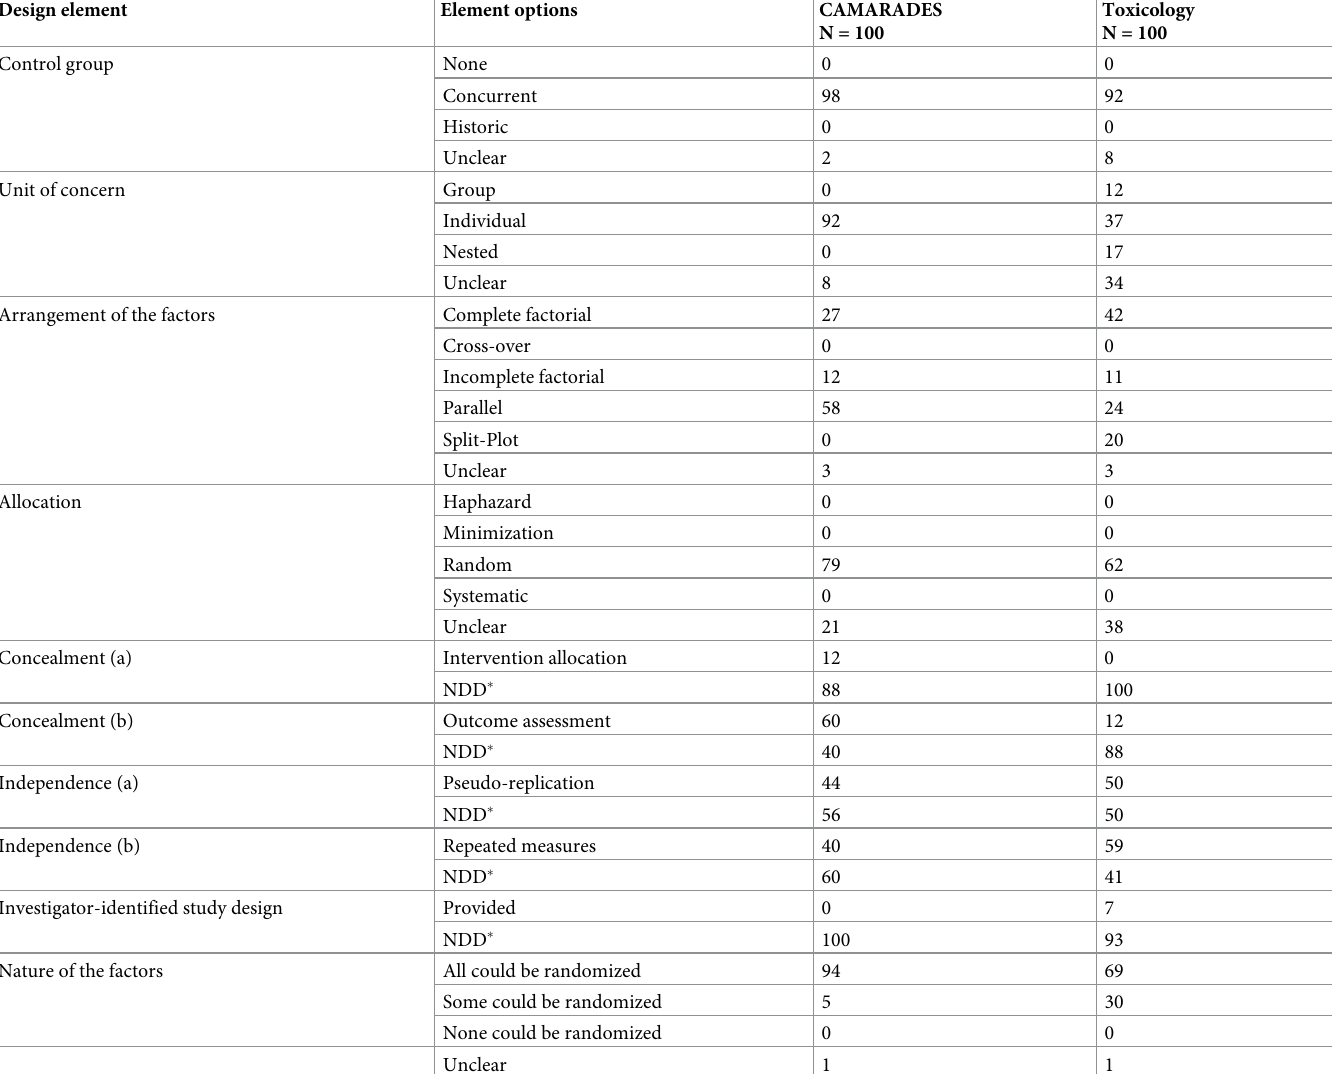
Table 2. Frequency of description of design elements and design element options in the two preclinical datasets evaluated (CAMARADES (brain trauma/stroke) and toxicology). Design